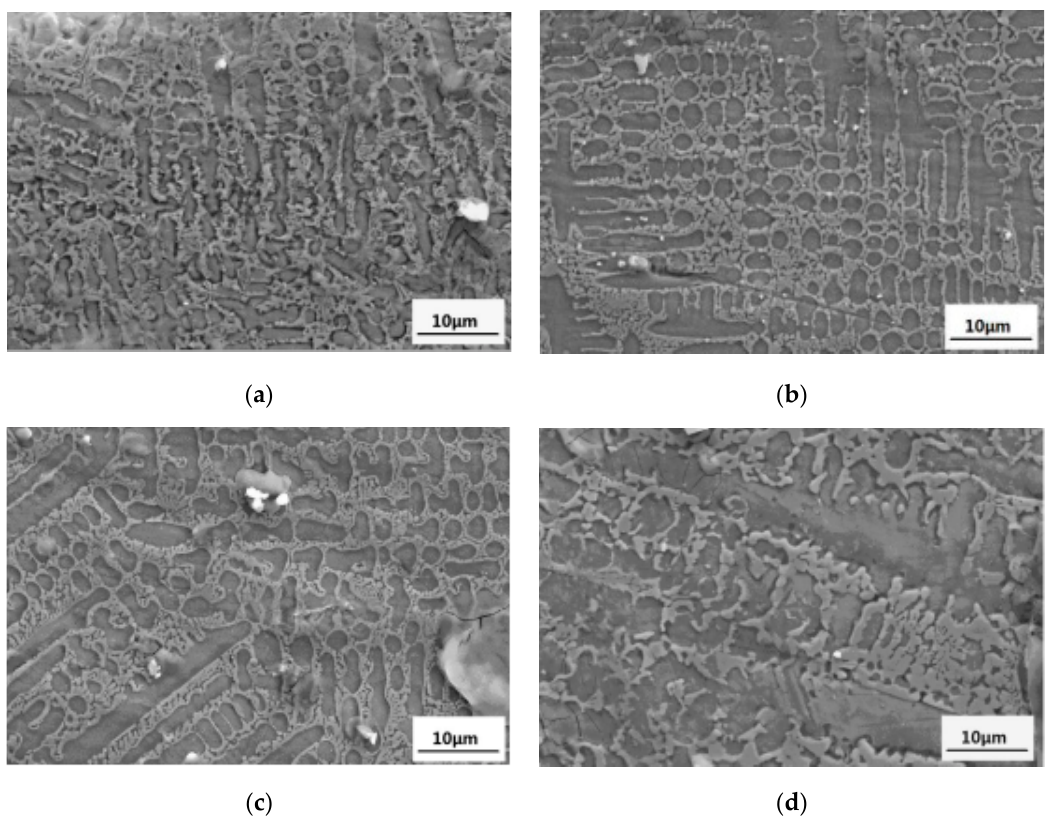
Figure 6. Internal microstructure of the cladding layer under different laser powers (65 Mn steel substrate): ( a ) 1200 W; ( b ) 1400 W; ( c ) 1600 W; ( d ) 1800 W.